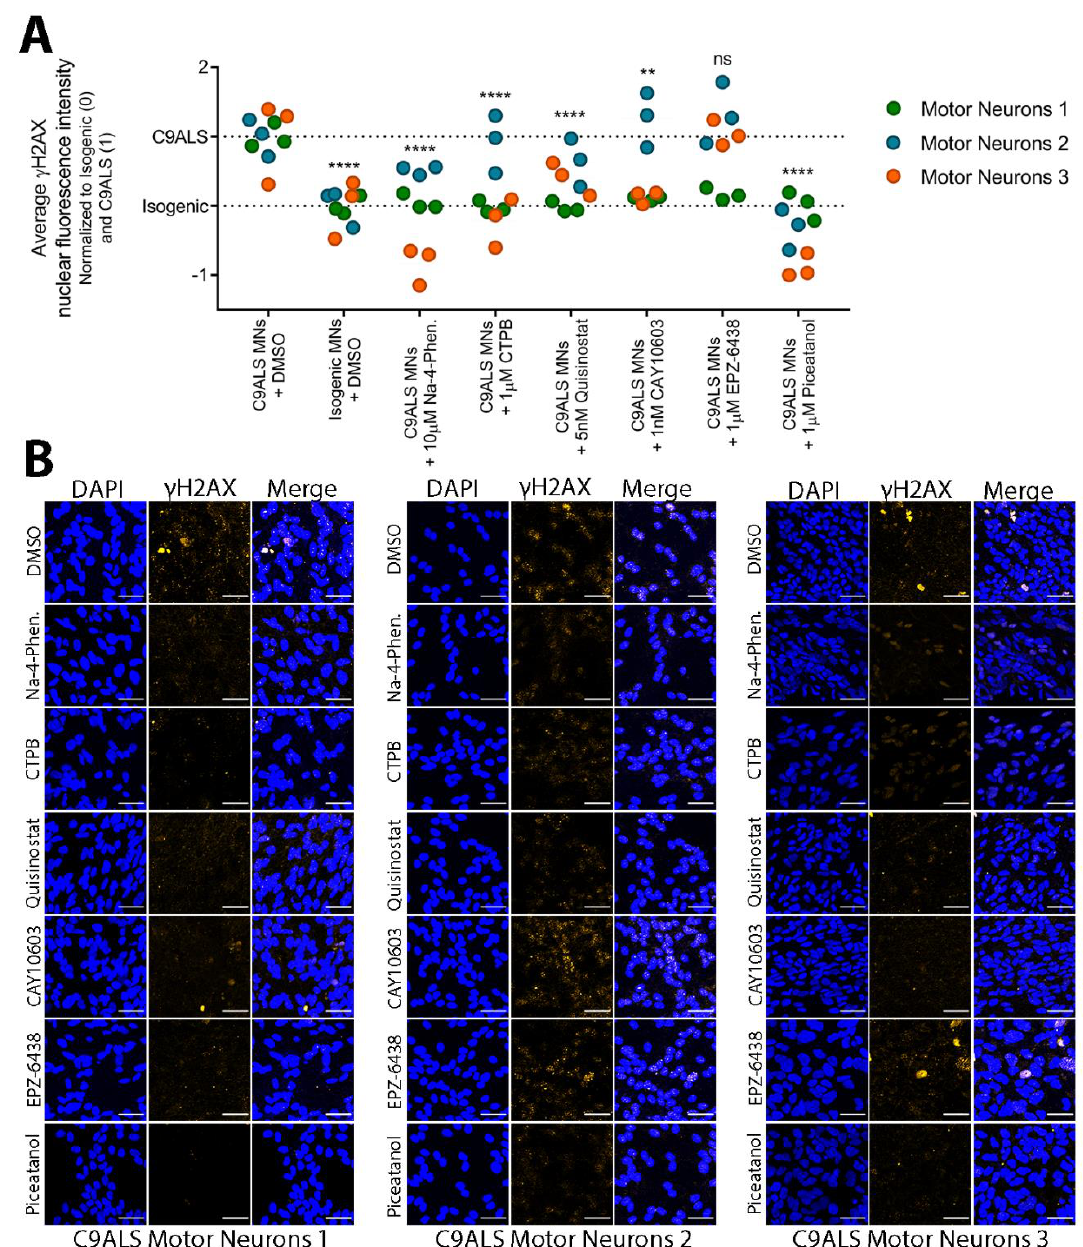
Figure 6. Small molecules targeting epigenetic modifiers decrease DNA damage marker γ H2AX in C9ALS patient iPSC- derived motor neurons. ( A ) Quantification of average γ H2AX nuclear fluorescence intensity in each C9ALS MN (C9ALS- 1—green; C9ALS-2—blue; C9ALS-3—orange) or their isogenic controls treated with either vehicle (DMSO) or various doses of the small molecules. Data was normalized across all three C9ALS MNs by setting baseline (0%) to the Isogenic + DMSO γ H2AX levels and setting maximum γ H2AX nuclear intensity (100%) to the C9ALS + DMSO γ H2AX levels. n = 3 biological replicates. There are 3 technical replicates per biological replicate. Each dot represents 1 technical replicate. Two-way ANOVA with multiple comparisons using Dunnett’s correction; F (7, 48) = 25.51; **** p < 0.0001; ** p < 0.01; ns = not significant. ( B ) Representative confocal images for data represented in ( A ), showing DAPI nuclei staining and γ H2AX (orange). Scale bar = 40 µ m. Semi-automated image analysis was carried out using confocal imaging and ImageJ. Statistical analysis performed in Graphpad